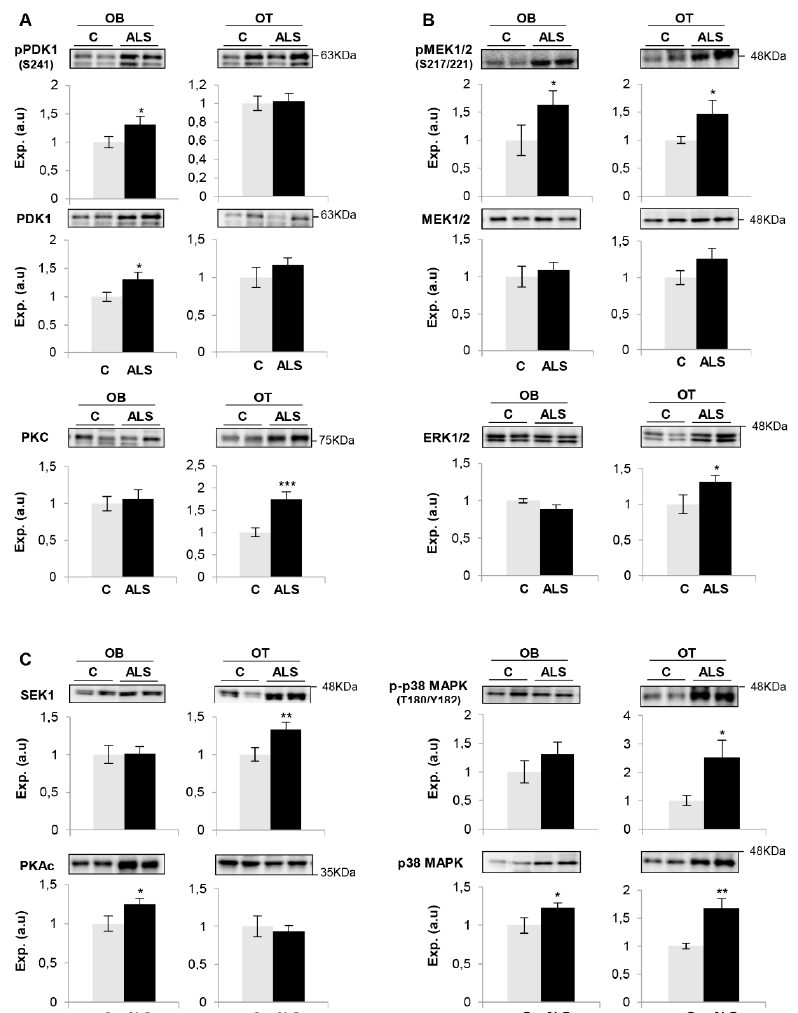
Figure 4. Signaling disruption across the OB-OT axis in ALS. State levels of PDK1, PKC ( A ), MEK1 / 2, ERK1 / 2 ( B ), SEK1, p38 MAPK, PKAc ( C ) across the OB-OT structures derived from controls and ALS subjects. Specific phosphorylation sites were also monitored in the case of PDK1, MEK1 / 2 and p38 MAPK. Data are presented as mean ± SEM. * p < 0.05 vs. control group; ** p < 0.01 vs. control group.